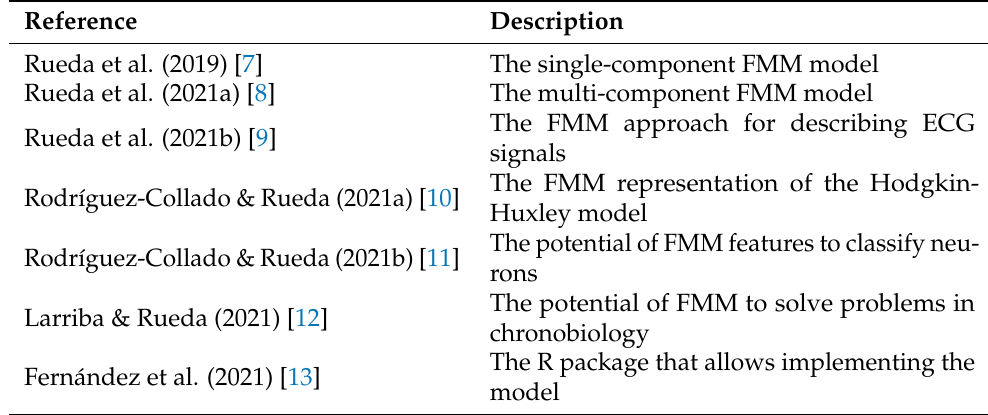
Table 1. Brief description of FMM related